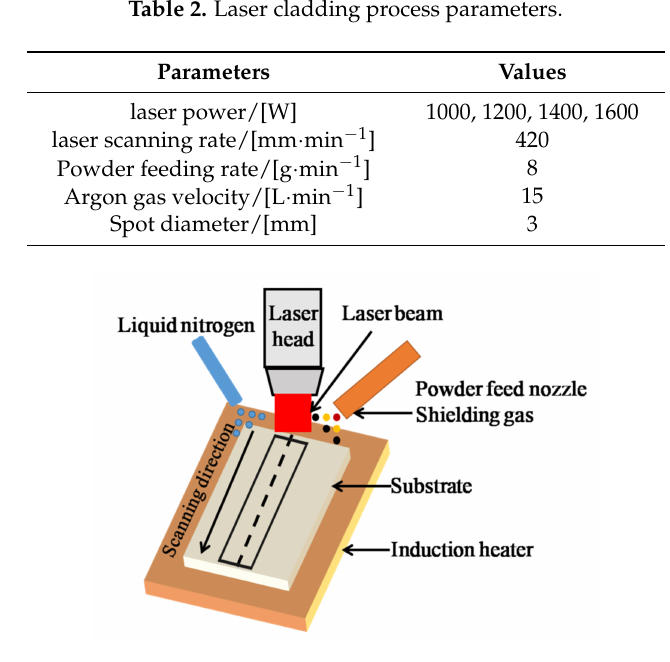
Figure 1. Schematic of laser cladding